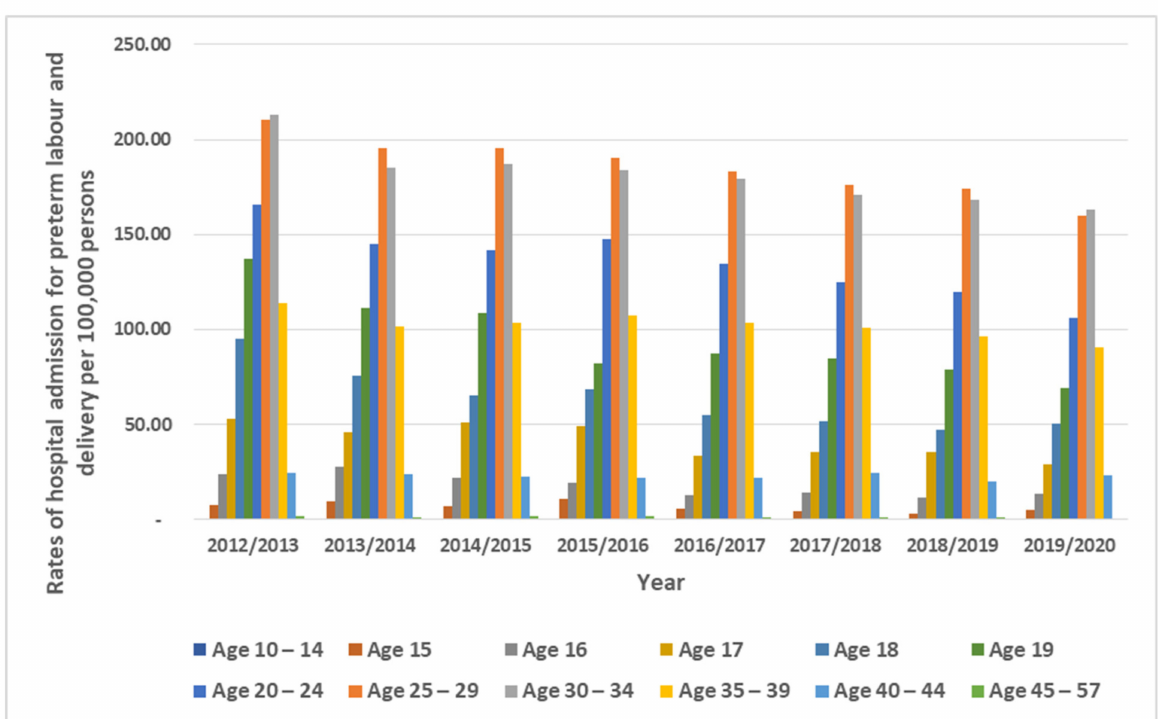
Figure 2. Rates of hospital admission stratified by age